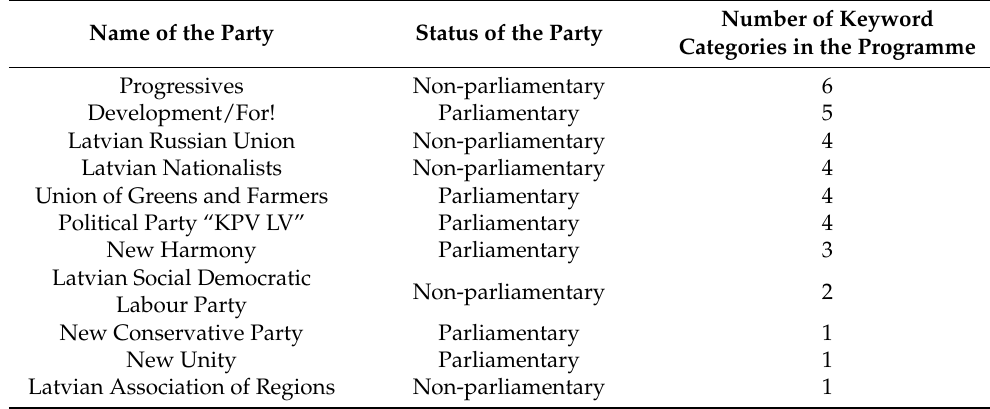
Table 3. Parties’ ranking according to the share of climate-related keywords in the programme.